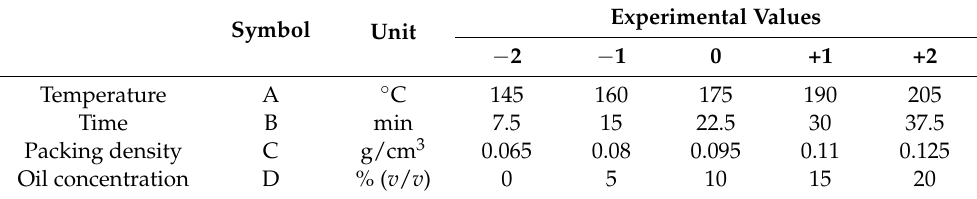
Table 2. Experimental values and levels of the selected independent factors for CCD